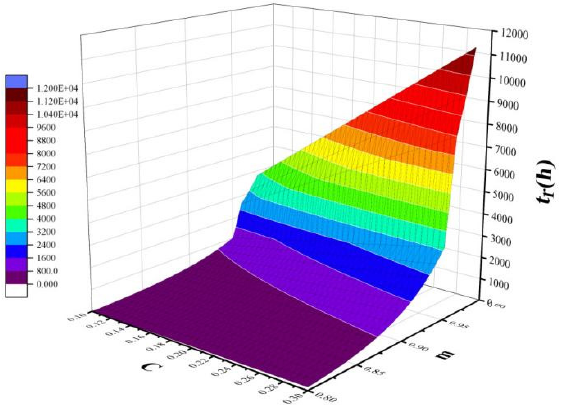
Figure 12. The influence of C and m constants in the Monkman–Grant model on the fracture life under the condition of constant minimum creep rate.